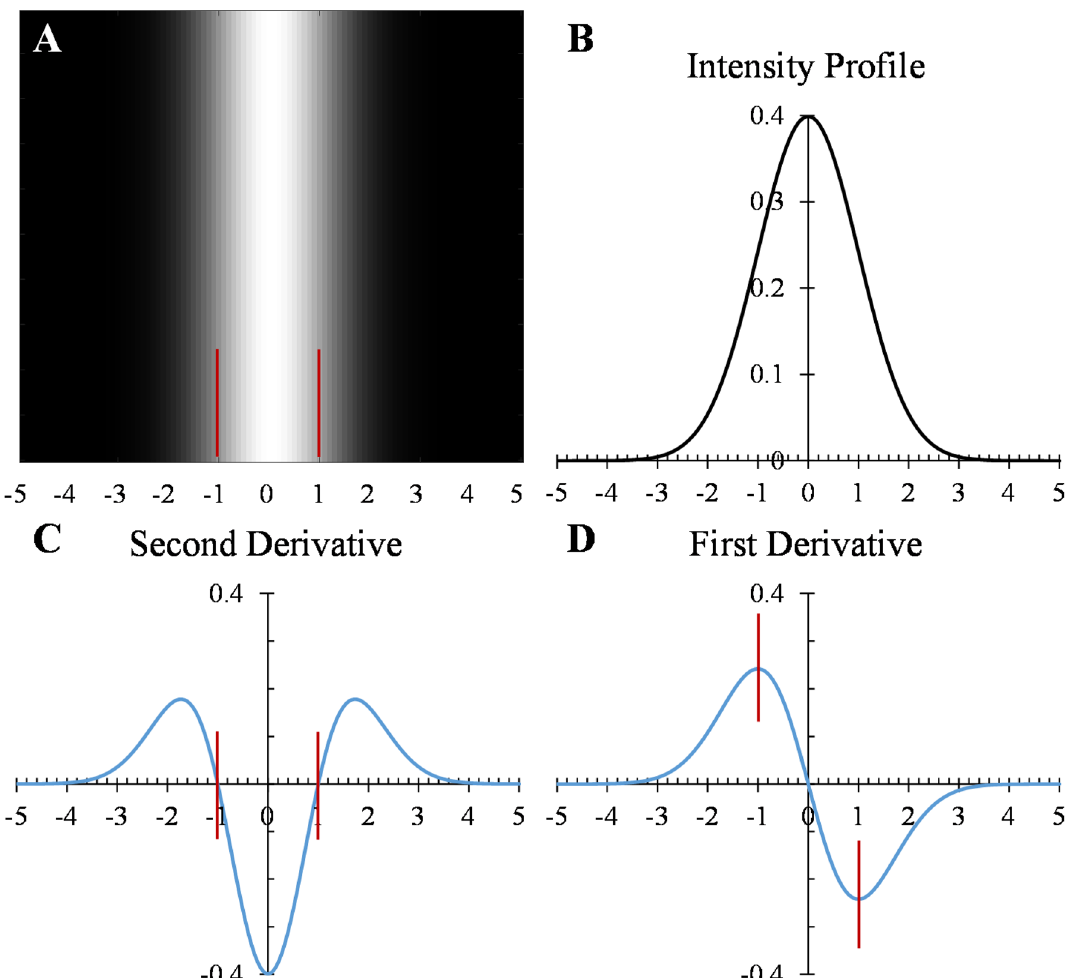
Figure 1. (A) Gray-scale image of a tube-like structure with (B) an intensity profile of 2-dimensional Gaussian with standard deviation s = 1. Zero-crossings of the second derivative (C) correspond to the local maxima in the first derivative (D)